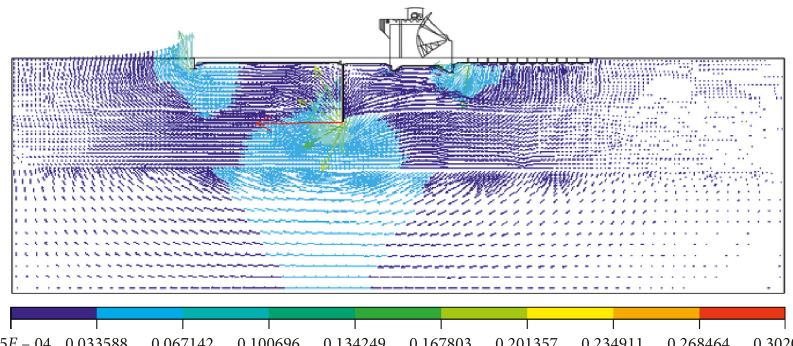
Figure 24: Seepage gradients in 1# sluice foundation in flood season.